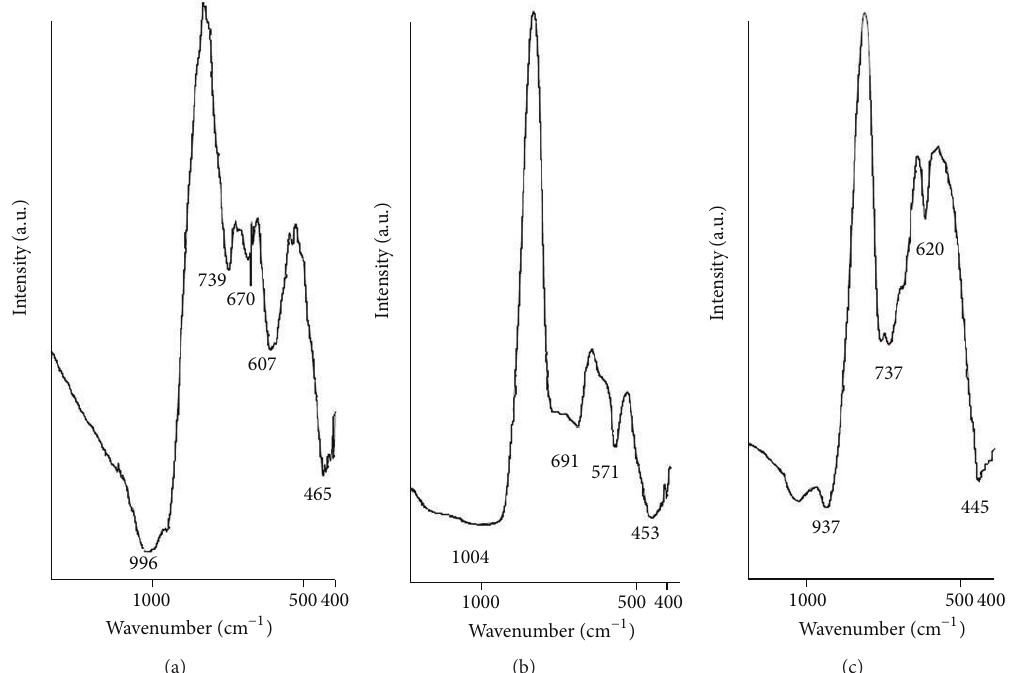
Figure 6: FT-IR spectra of synthesized three types of zeolites under template free condition from the same initial gel compositions (a) zeolite Y, (b) zeolite P, and (c)